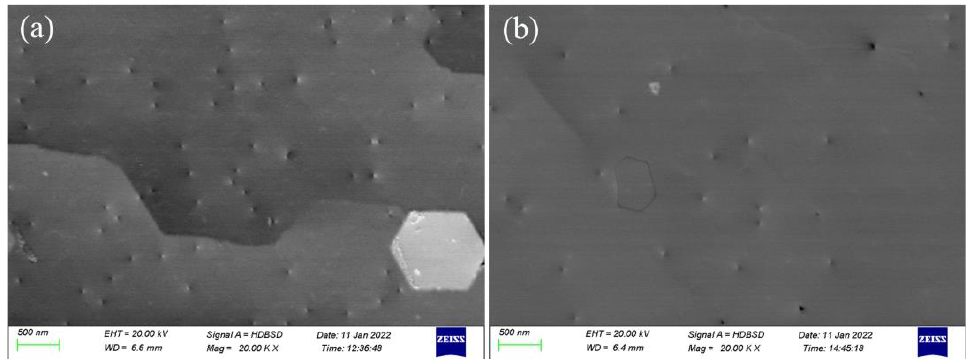
Figure 7. Electron channel contrast imaging ( a ) sample Sc and ( b ) sample Sp.